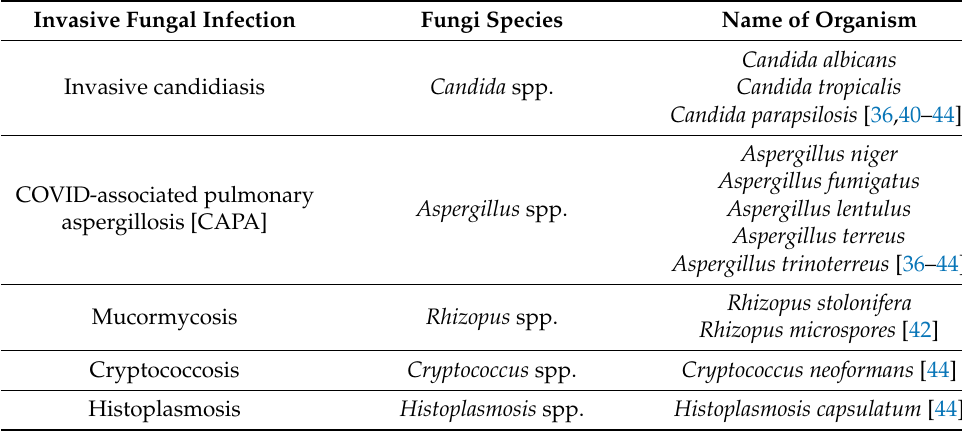
Table 3. Opportunistic mycoses in COVID-19 infection. Invasive Fungal